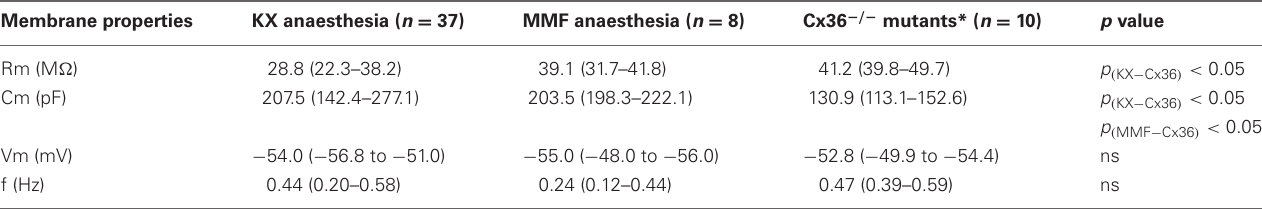
Table 1 | Membrane properties of in vivo olivary neurons under different anaesthetic and genetic conditions. Membrane